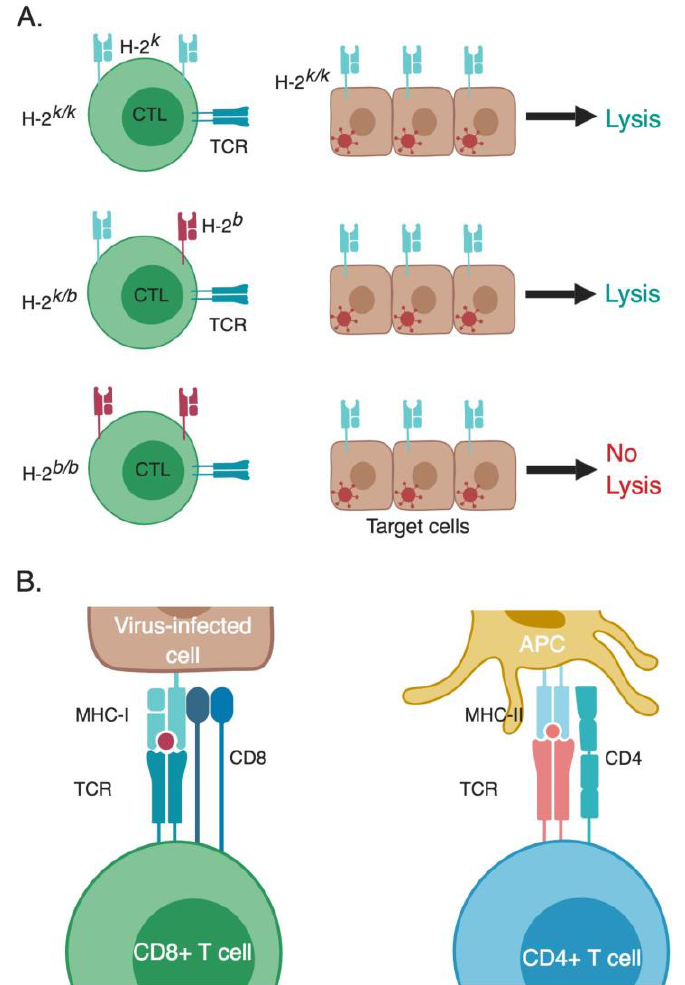
Figure 2. MHC restriction of T-cell responses. ( A ) Doherty and Zinkernagel experimental design for their Nobel Prize winning studies. They tested the ability of splenocytes from LCMV-infected mice with different H-2 backgrounds to lyse LCMV-infected mouse fibroblasts with an H-2 k/k background. Only CTLs that are H-2-compatible with the target cells were able to lyse them (in this specific experiment possessed at least one allele that is H-2k, either H-2 k/k or H-2 k/b ). Non-infected target cells co-cultured with CTLs having a matching MHC H-2 served as a negative control (not shown in the figure). ( B ) CD4+ and CD8+ T cells recognize their cognate epitopes that are presented within the context of MHC class II and I, respectively. These peptides are processed from foreign antigens and then presented to T cells. APC, antigen-presenting cell; CTL, cytotoxic T lymphocyte; MHC, major histocompatibility complex; TCR, T-cell receptor. * The different cells, receptors, ligands, and molecules are not drawn to scale. ** Created with BioRender.